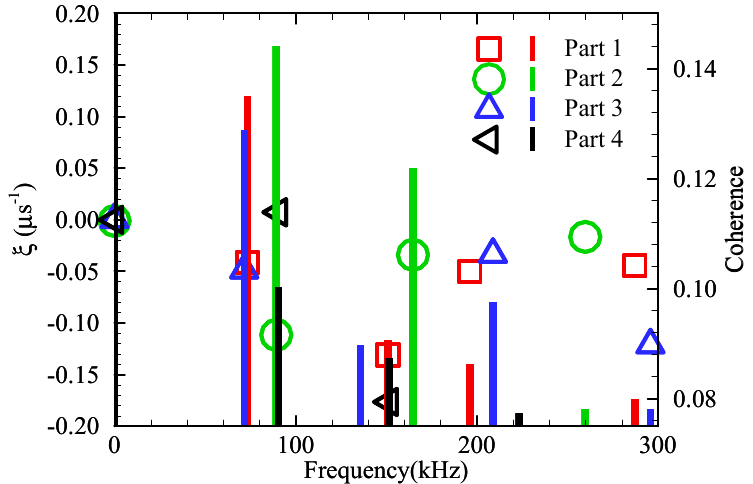
Figure 21. Temporal characteristics of the decomposed modes. Symbols indicate the growth rate and bar lines indicate coherence. (markers—growth factor; bars—normalized coherence)